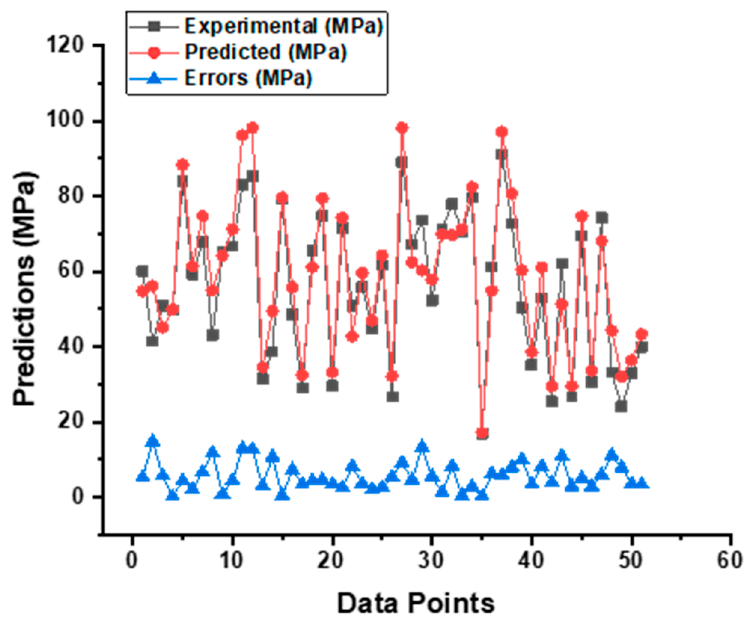
Figure 11. Indication of the error’s difference between the actual and forecasted CS result of SCC from SVM model.